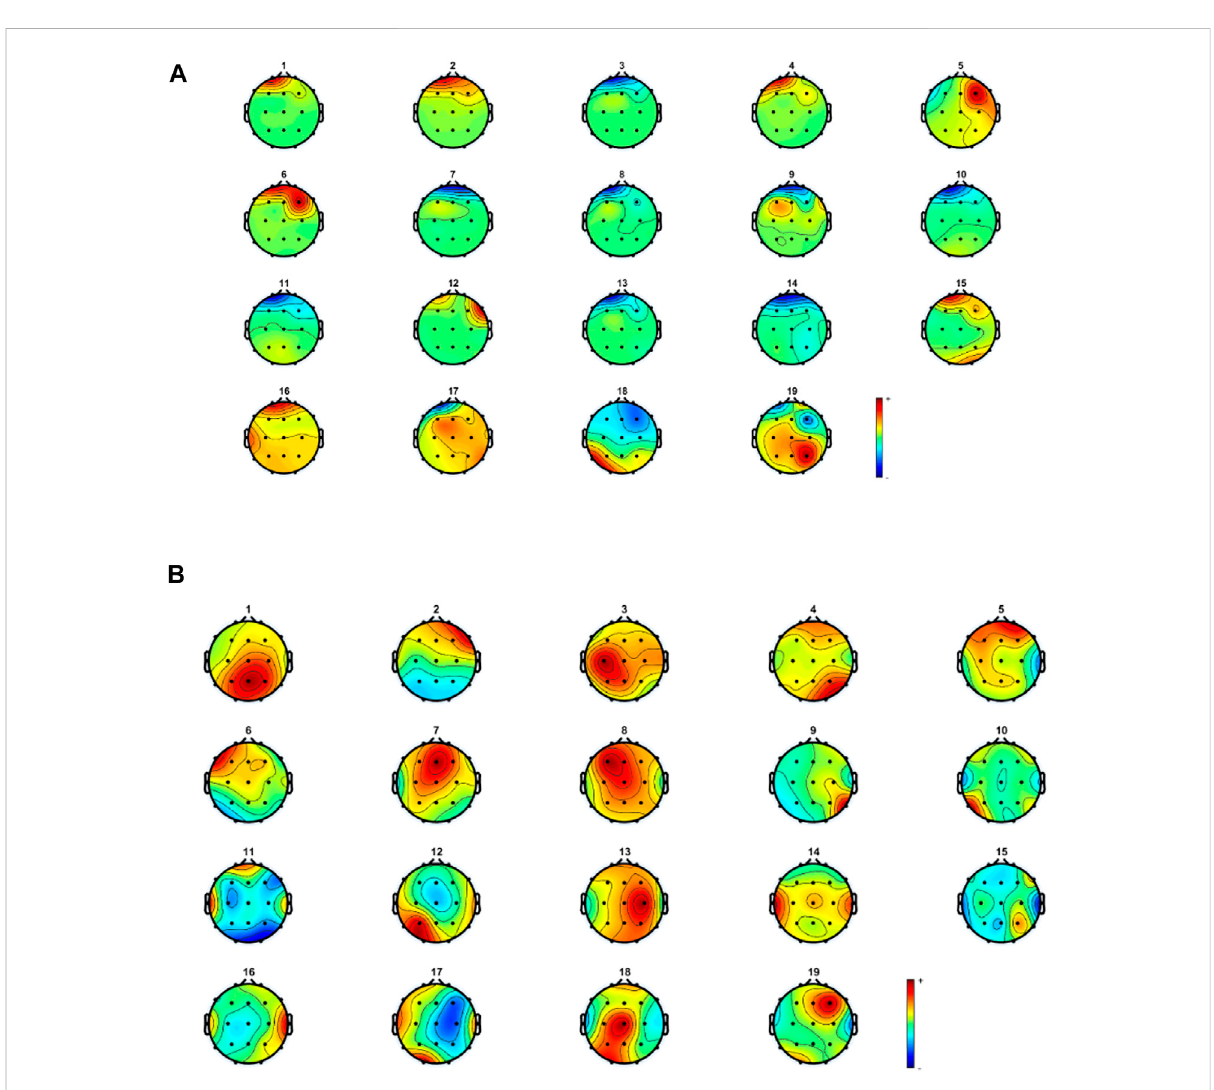
FIGURE 10 Topography maps for components related to (A) contaminated and (B) reconstructed and cleaned